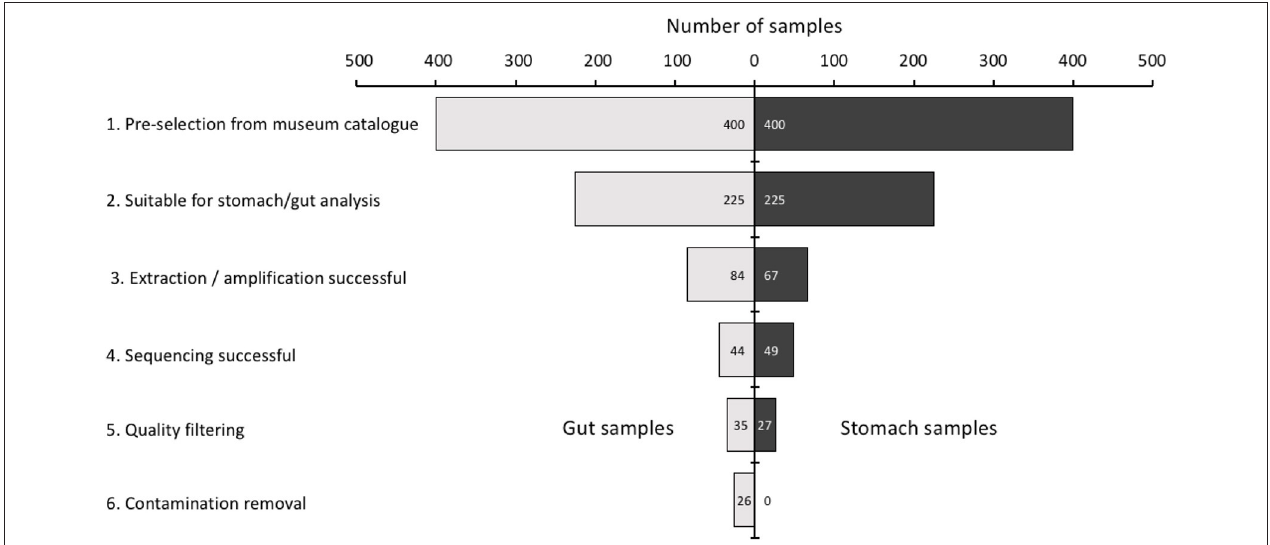
FIGURE 1 | Vertical bar chart showing the remaining sample size for museum gut (16S gene, gray) and museum stomach (COI gene, black) content analysis after every DNA metabarcoding pipeline